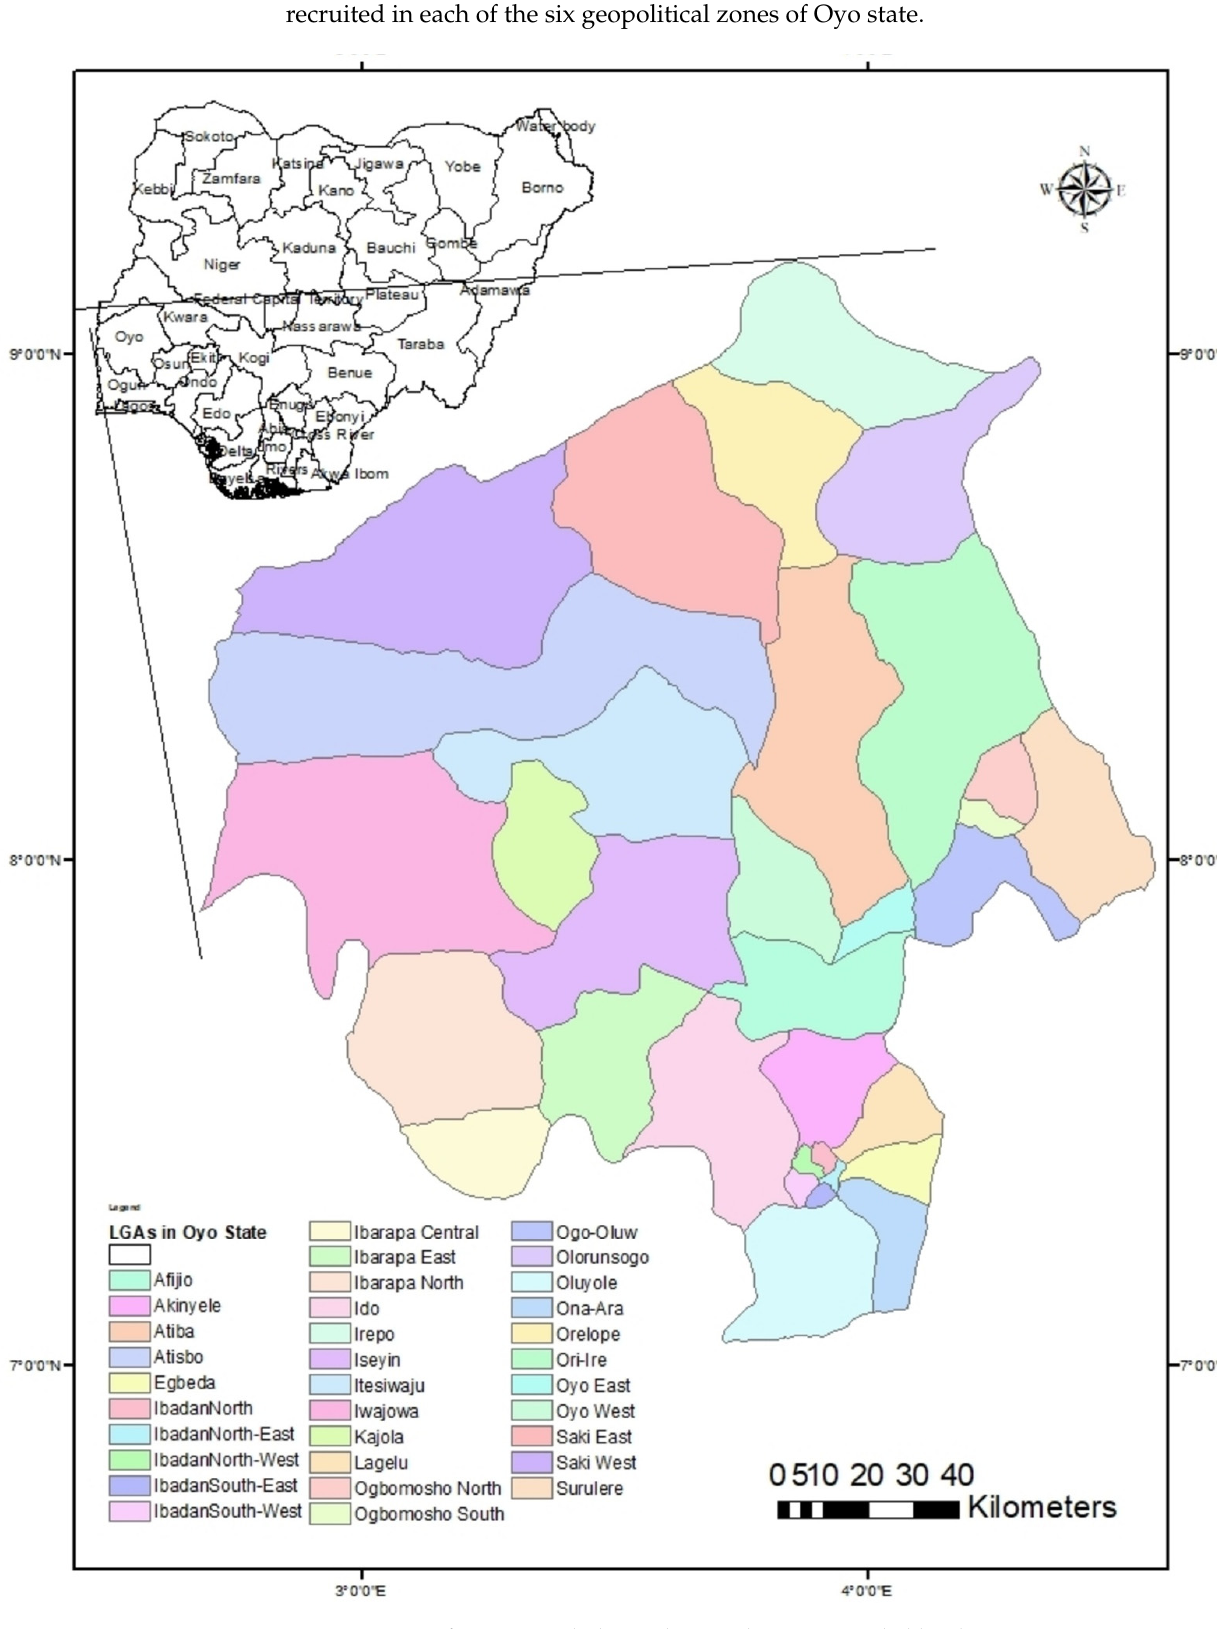
Figure 1. Map of Nigeria with the study area showing sampled local government.